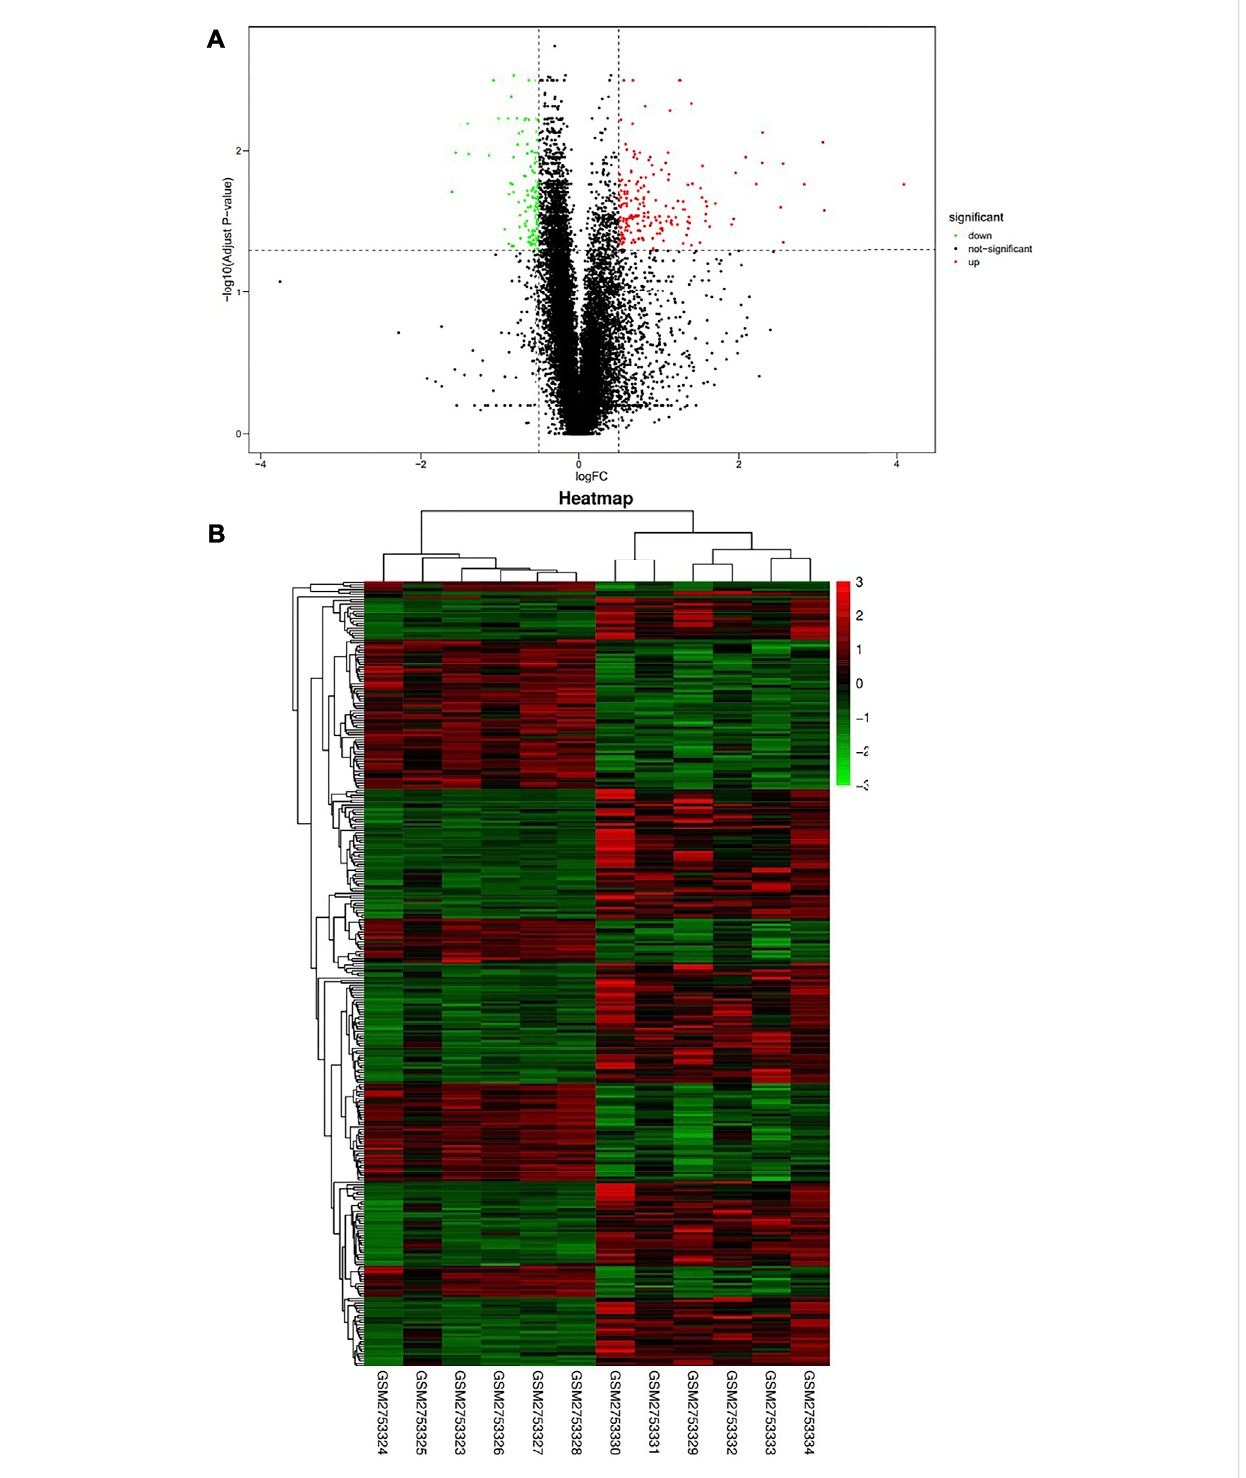
FIGURE 1 ScreeningofdifferentiallyexpressedgenesinWideTypeandRETNullsamples. (A) Volcanoplotofdifferentiallyexpressedgenes(reddotsrepresent upregulated genes, green dots represent downregulated genes); (B) Heat map of differentially expressed genes (high gene expression levels were indicated in red, low gene expression levels were indicated in green). GSM2753324-28 were RET Null and GSM2753329-34 were Wide